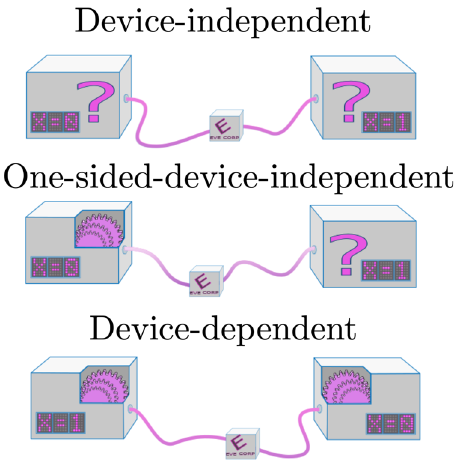
Fig. 1 Levels of device assumptions. Under device-dependent (DD) assumptions, all measurements and their underlying Hilbert spaces are characterized. Under fully device-independent (DI) assumptions, none of these are known, and we only assume the validity of quantum mechanics. One-sided device-independent (1sDI) assump- tions lie between these two cases. For the 1sDI setting, we consider the case where one party ’ s measurements are fully characterized while the others ’ are unknown (e.g., see Refs. 58,59 ).